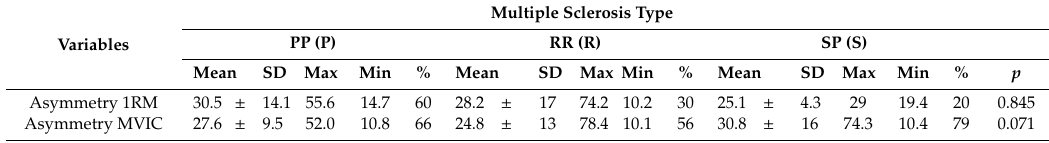
Table 9. Asymmetry of sample by type of multiple sclerosis.